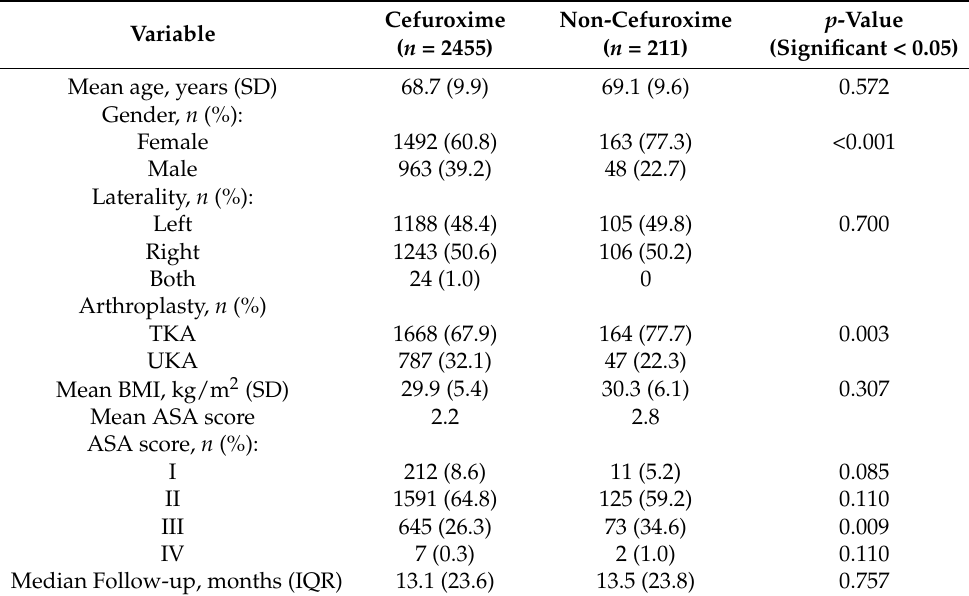
Table 2. Demographics in knee arthroplasty group according to prophylactic